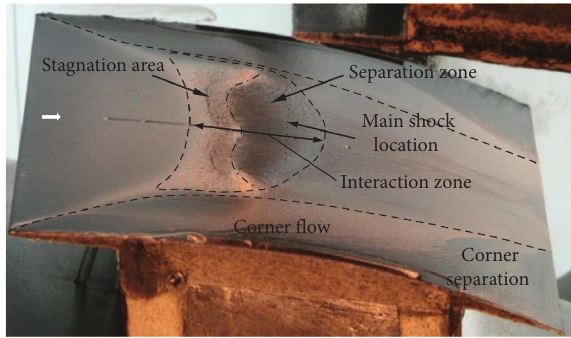
Figure 5: Oil visualization for the reference